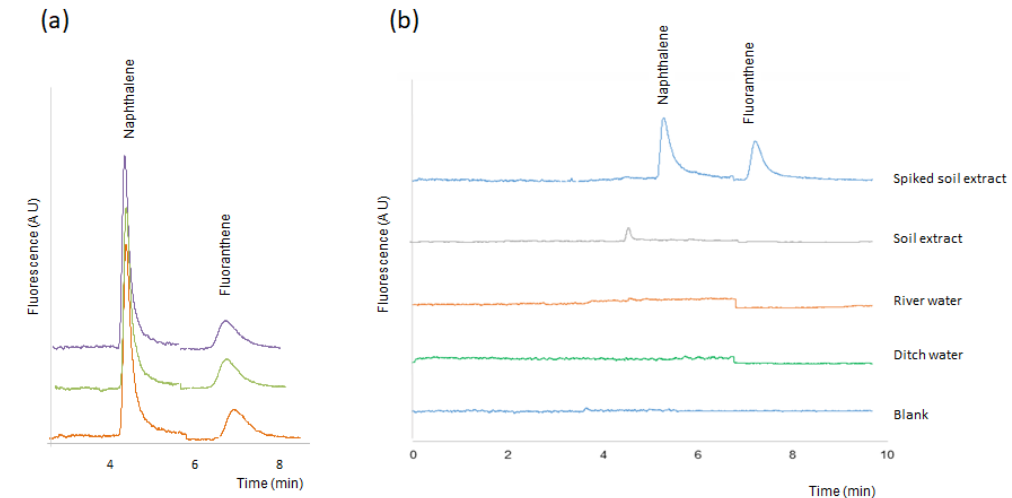
Figure 2. Chromatograms obtained under optimized conditions for ( a ) three successive injections of a standard solution containing 2.5 µg/mL of naphthalene and 0.18 µg/mL of fluoranthene; ( b ) a blank (nanopure water), ditch and river water, and for the extract obtained for a soil sample, and the same soil spiked with naphthalene and fluoranthene. Volume of working solution processed, 200 μL.